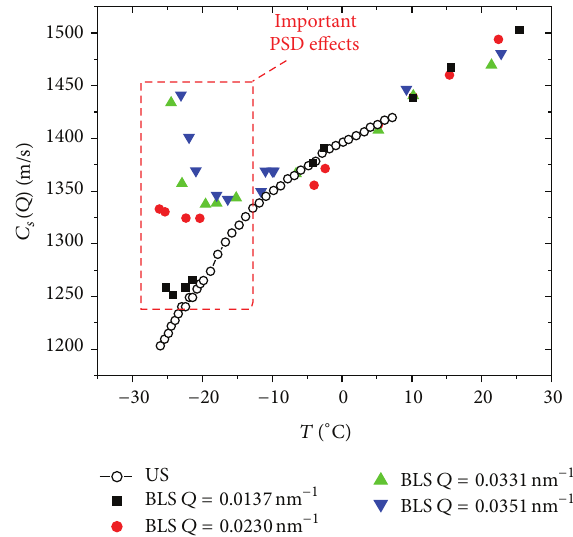
Figure 5: The 𝑇 -dependence of the sound velocity is reported as measured by US ([33]) and by BLS ([7]) at the indicated 𝑄 values in both normal liquid and supercooled